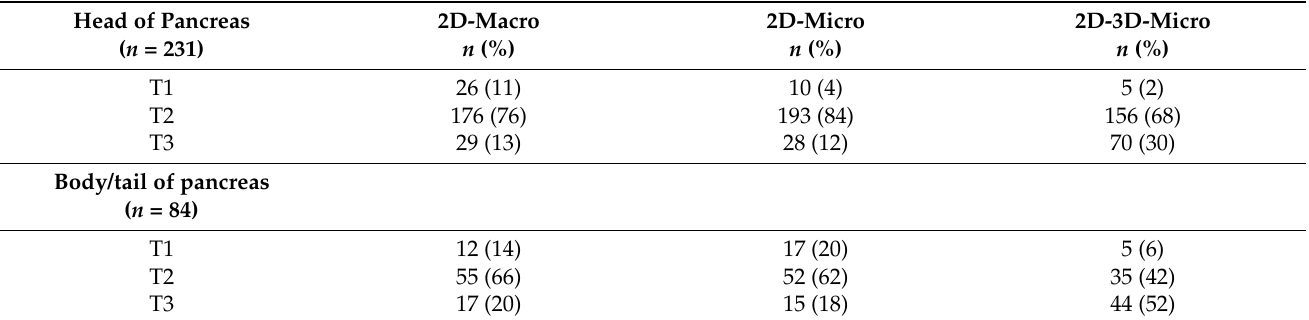
Table 5. Distribution of T-stage based on various approaches to tumour size